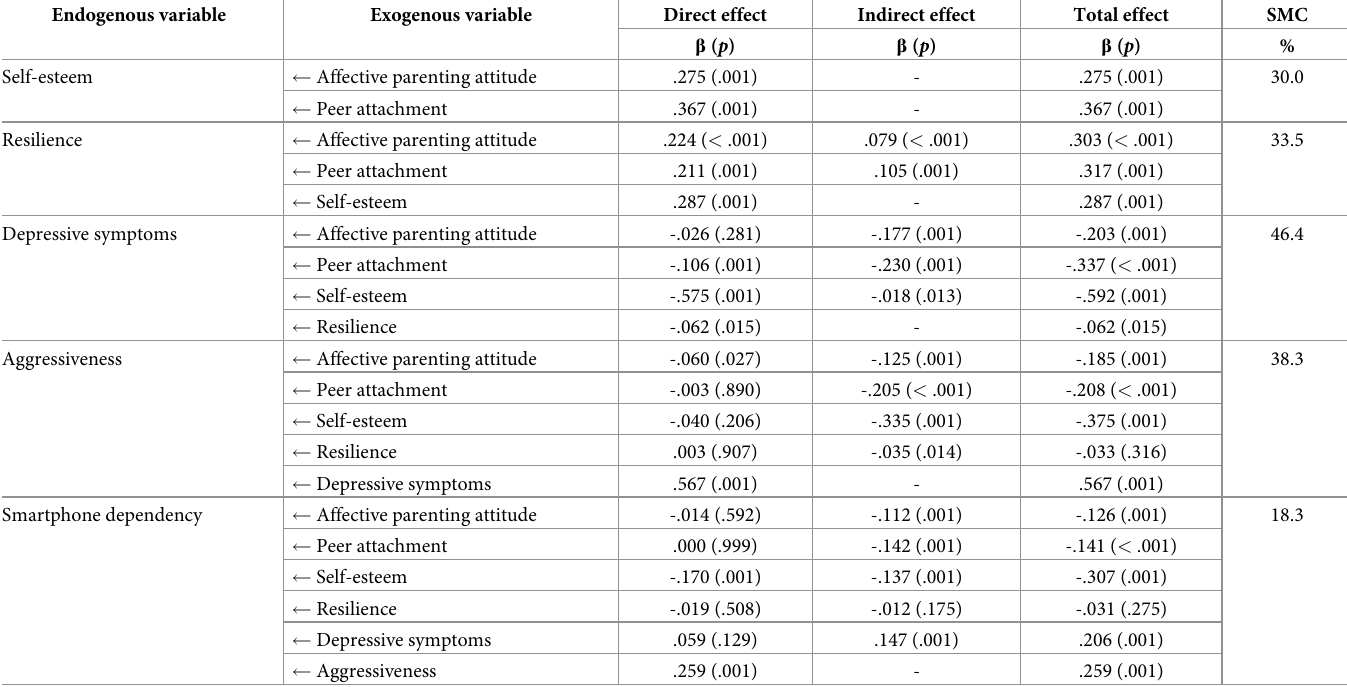
Table 3. Standardized direct, indirect, and total effects of study variables (N =